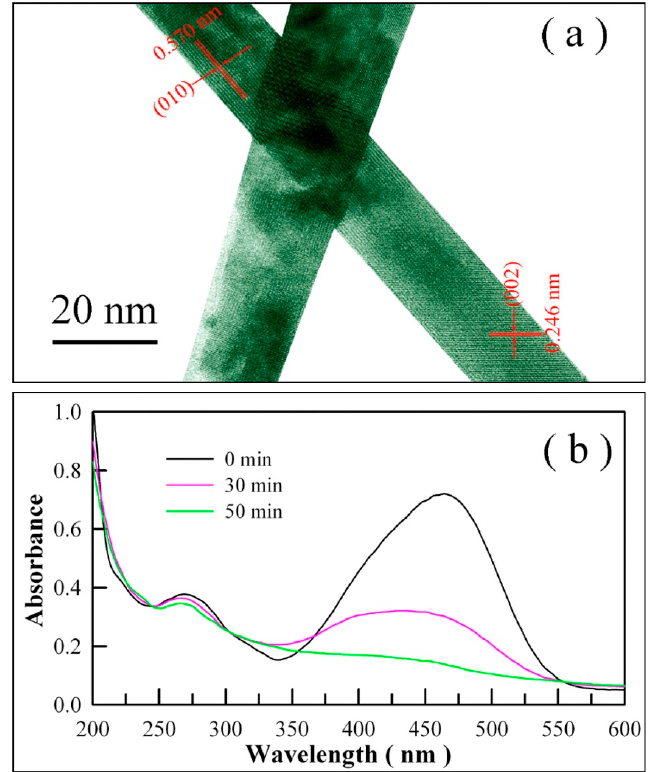
Figure 16. ( a ) High-resolution TEM micrograph of one ZnWO 4 nanoplate with a {100} facet; ( b ) absorption spectra of methyl orange solution as a function of UV irradiation time in the presence of ZnWO 4 nanoplates with a {100}